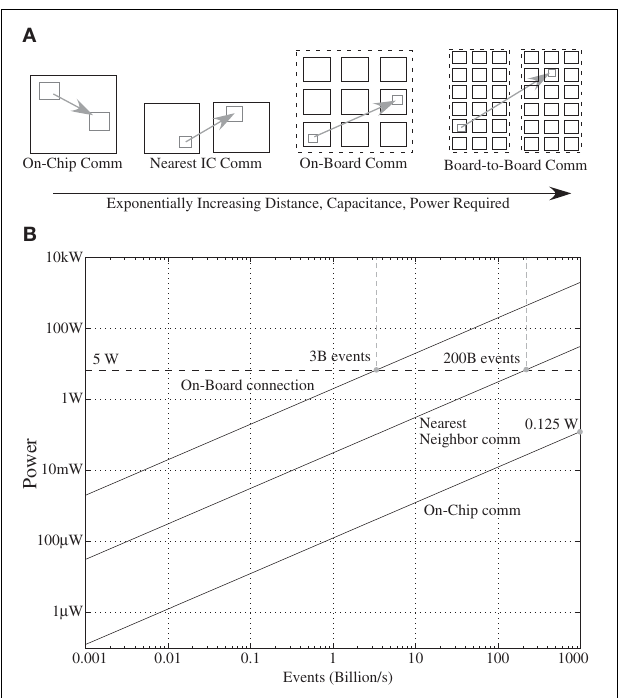
FIGURE 21 | Modeling of power required for transmitting an event. (A) We consider computation between devices on a single IC, between neighboring ICs, on a single board, and distances beyond a single board (i.e., between two boards). Each of these steps requires considerably more power for communicating the resulting event; the more local the communication, the more power efficient the resulting computation. (B) Communication power versus number of events (Gbit) communicated. We consider the three cases of transmitting a bit on a chip (average C L = 1pF, V dd = 0.5V) , transmitting a bit to a neighboring chip (average C L = 10pF, V dd = 2.5V), and transmitting an event address of 8 bits on a board (average